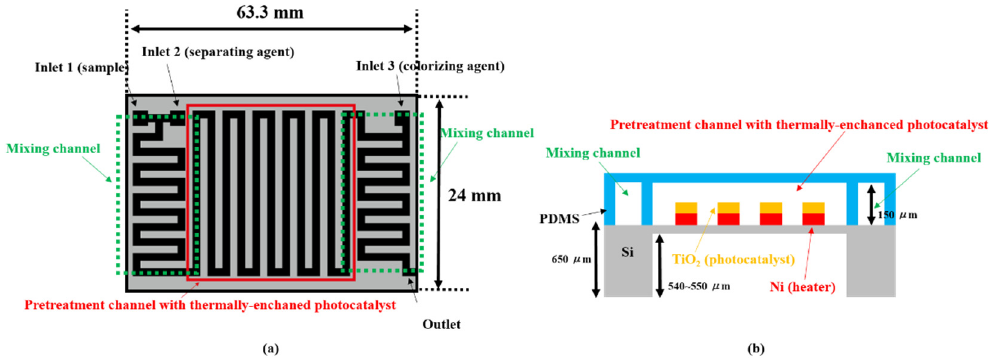
Figure 2. Schematic of the proposed TP pretreatment microfluidic chip. ( a ) Top view, ( b ) side view.